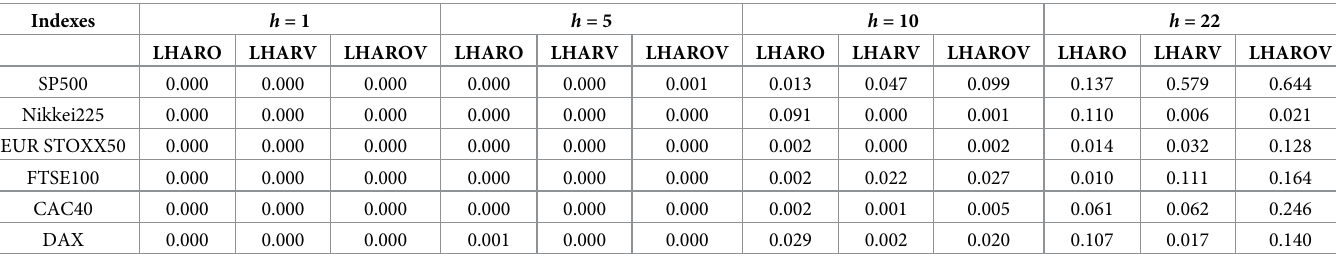
Table 11. The tests of forecasting performance comparation between daily lagged and long lagged models (different model setting).